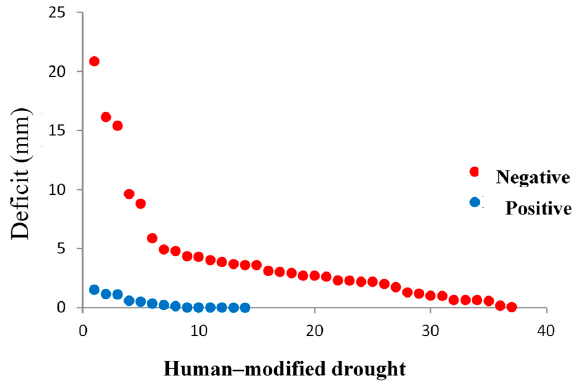
Water 2019 , 11 , 884 Figure 12. The distribution of modified droughts during a year for Eskandari (the 80th threshold value).